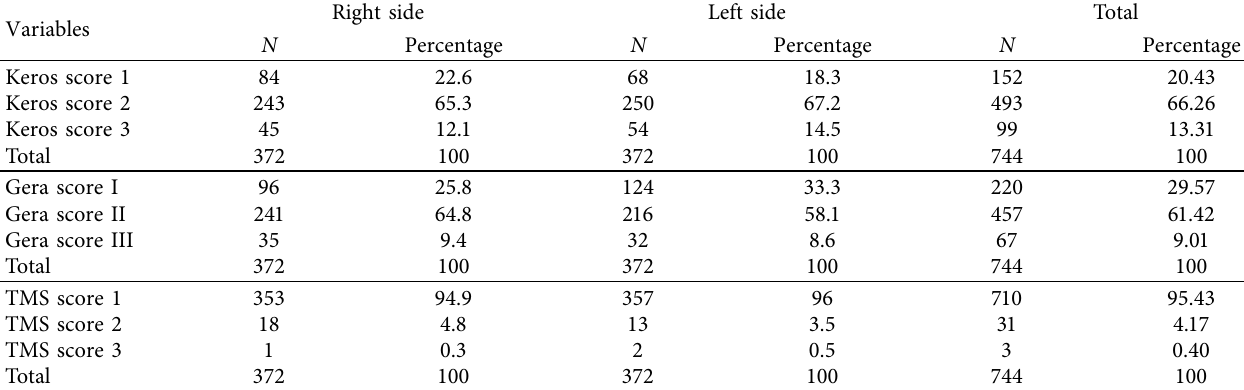
Table 2: The distributions of Keros, Gera, and TMS classification scores according to the side. Right side Left Variables